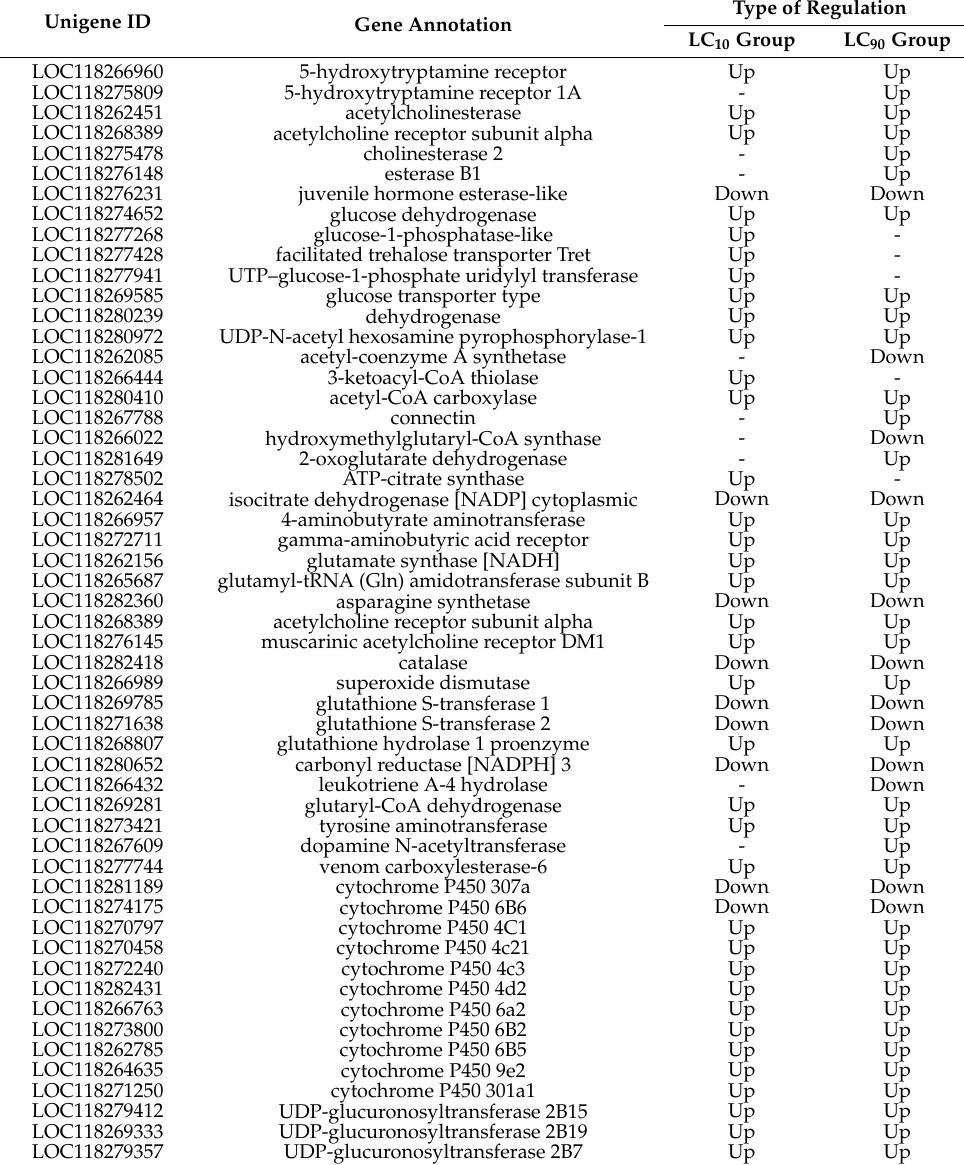
Table 2. Changes of key genes in S. frugiperda by exposure to LC 10 and LC 90 concentration of the spinetoram compared to the control group ( t -test p <